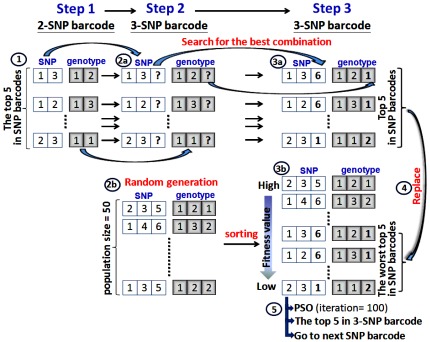
Population initialization using conservation of the best 5 results.